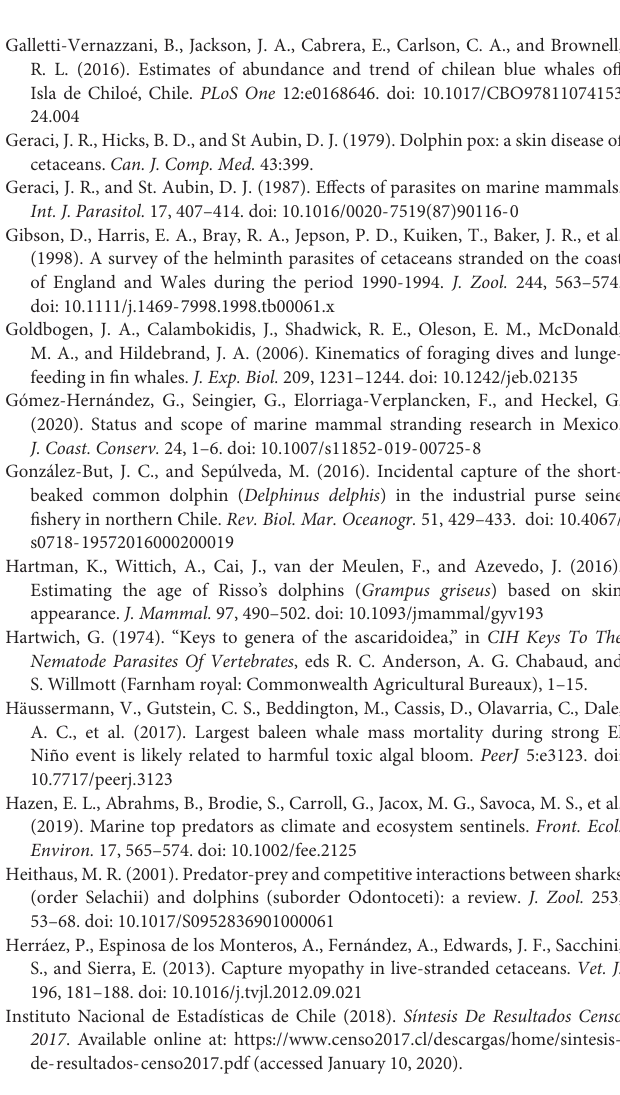
FIGURE S1 | Lesions in Fin whale ( Balaenoptera physalus ) stranded in Santo Domingo due to large vessel trauma. There are several transversal hematomas in the peduncle, most likely caused by a large vessel propellers. FIGURE S2 | A stranded Orca ( Orcinus orca ). (A) Multiple parallel skin lacerations (rake marks) throughout the body. (B) Details of rake marks ( ∼ 20 mm apart) over the melon. FIGURE S3 | Micrograph of the heart of a Dusky dolphin ( Lagenorhynchus obscurus ). There is Sarcocystis spp-like cyst within a